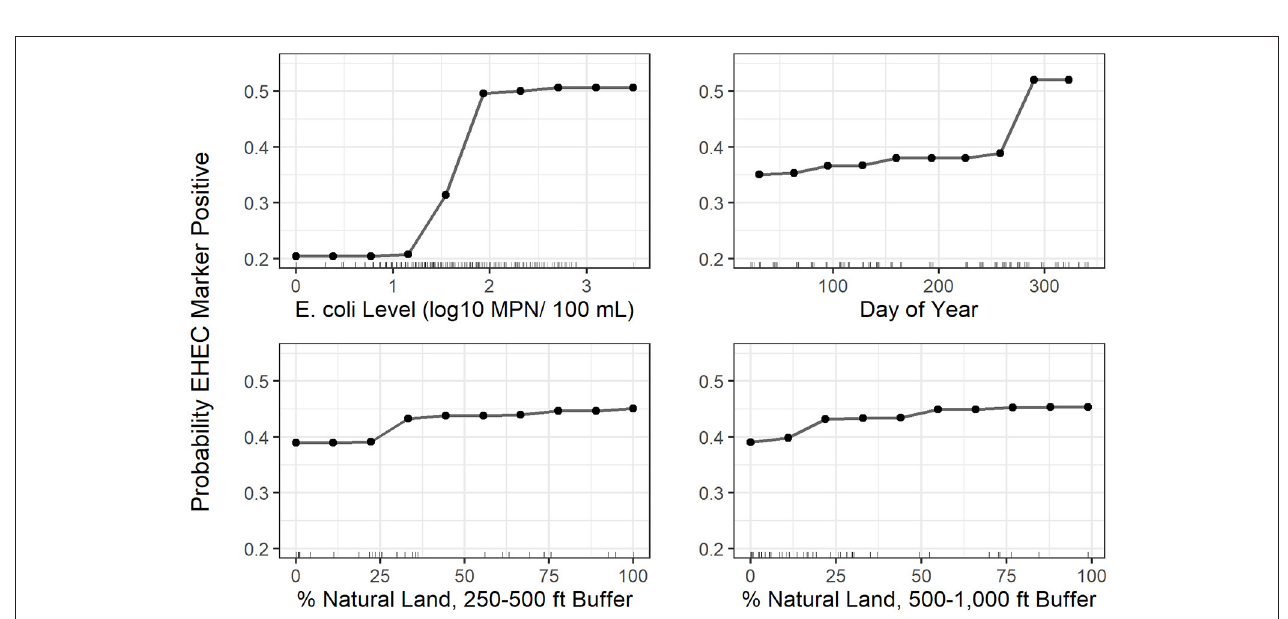
FIGURE 4 | Partial dependence plots for the 4 top-ranked predictors according to variable importance in the EHEC marker conditional forest model with generic E. coli included as a predictor; the plots indicate how the predicted probability of a water sample being positive for EHEC marker detection changes as the x-axis variable (predictor) changes. The tick marks along the x-axis indicate values of the predictor variable in samples used to fit the conditional forest